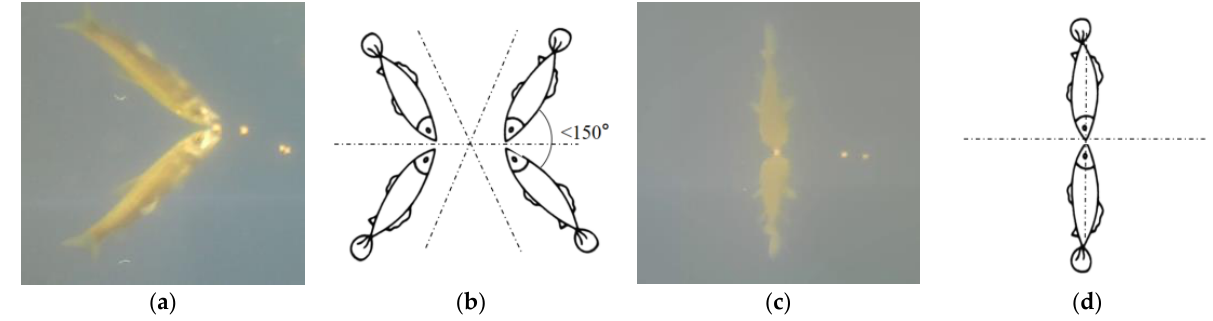
Figure 2. Two typical characteristics of fry feeding: ( a , b ) angle feeding images; ( c , d ) vertical feeding images.